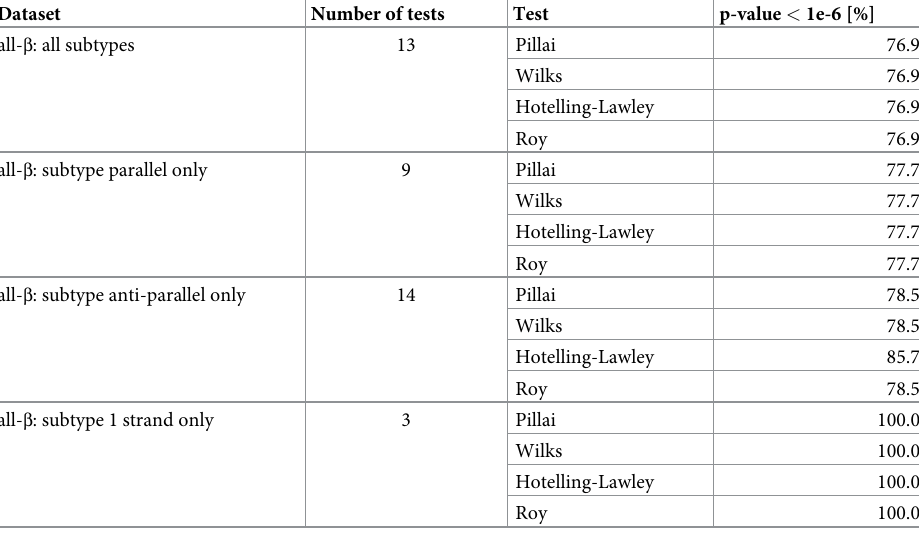
Table 5. Results of the MANOVA test applied to the all- β protein type dataset.